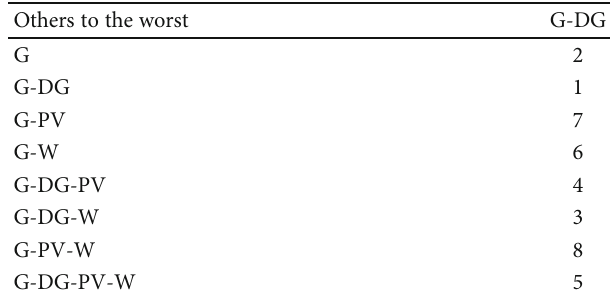
Table 6: Scale of other criteria with worst criteria.